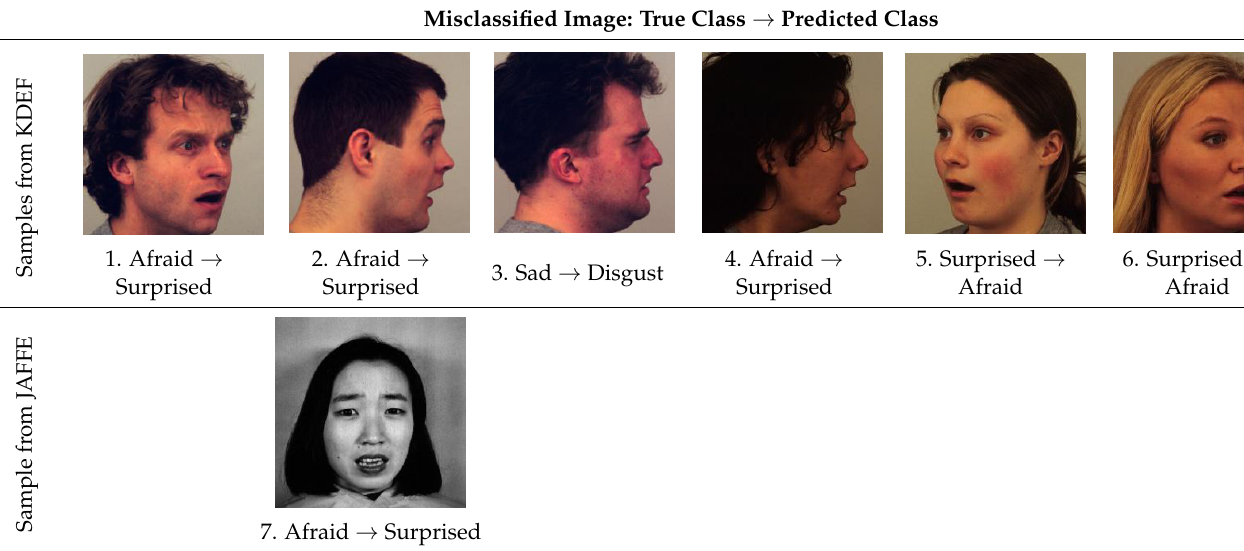
Table 5. Misclassified images from KDEF and JFEE datasets with their original and predicted class labels. Misclassified Image: True Class → Predicted